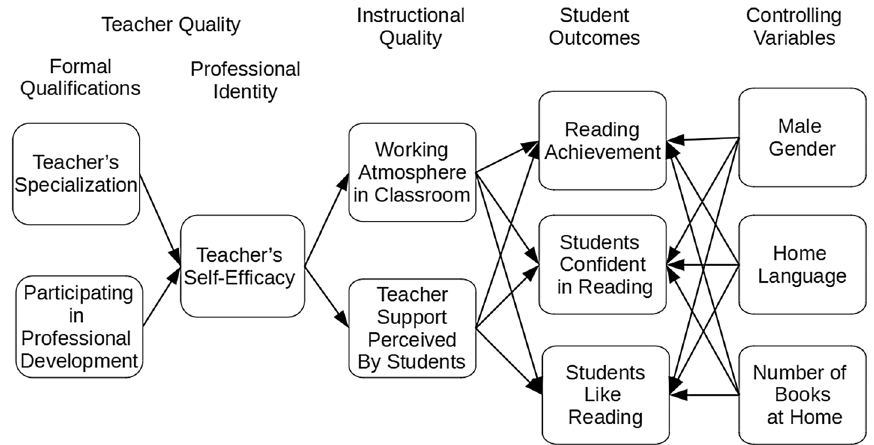
Fig. 2 Variables and paths in the path analysis